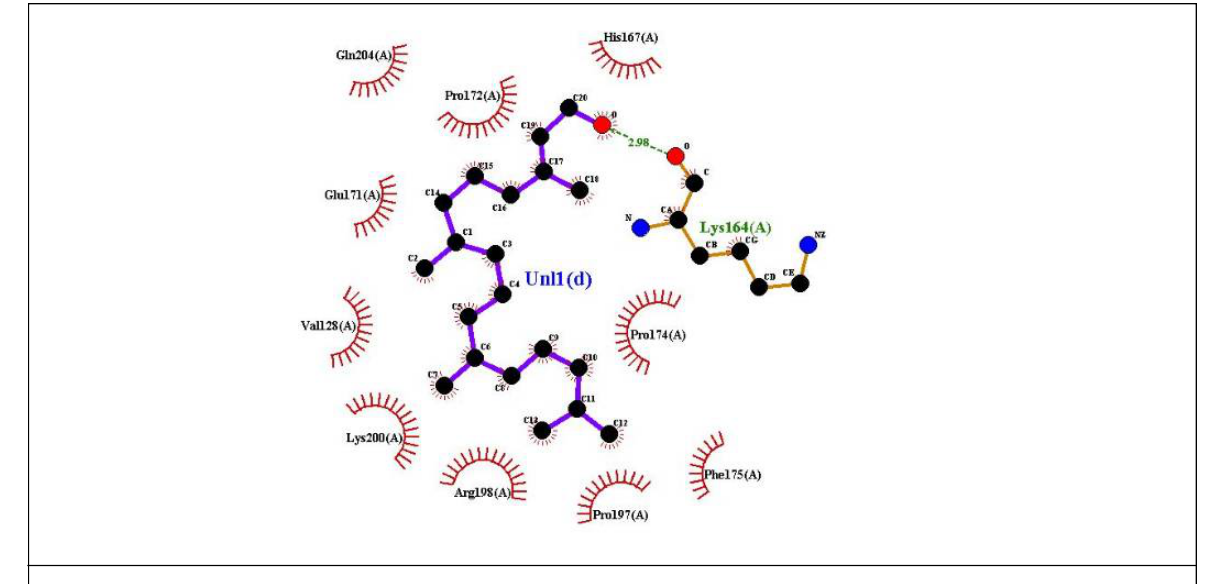
Figure 1: Protein-ligand interaction of complex Cathepsin B1_3,7,11,15-Tetramethyl-2-hexadecen- 1-ol Note: In the interaction between Cathepsin B1 (protein) and 3,7,11,15-Tetramethyl-2-hexadecen- 1-ol (ligand), the ligand form single hydrogen bond (represented as broken lines with bond length) with amino acid Lys164 of protein.